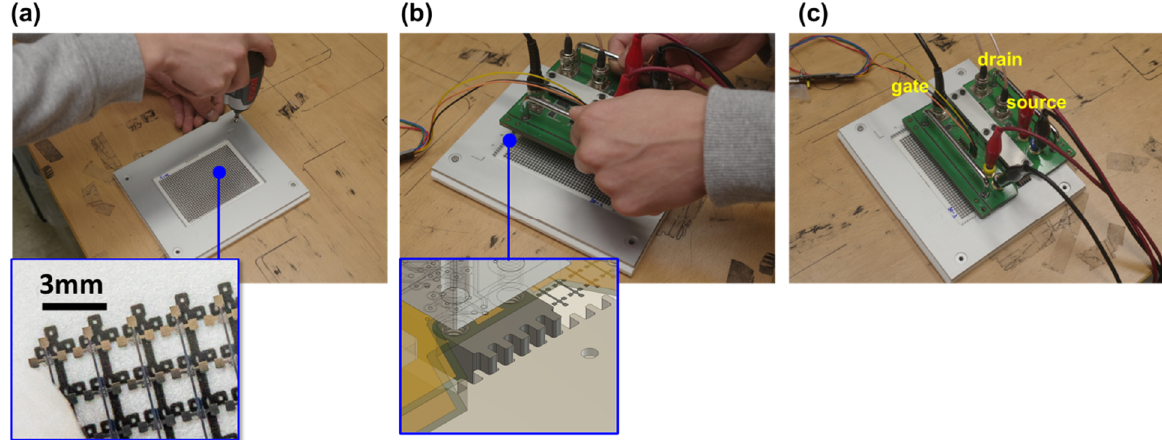
Figure 3. Images depicting the stepwise process for assembling the PICR2R-TFT array probing system: ( a ) Alignment of the SWCNT-TFT array onto the base and installation of the cover to hold the array in place. ( b ) Fitting the probe instrument onto the fastening cover with an inset showing the jigsaw-shaped teeth to properly align the probe head. ( c ) The connection of gate, source, and drain lines in the PICR2R-TFT system.